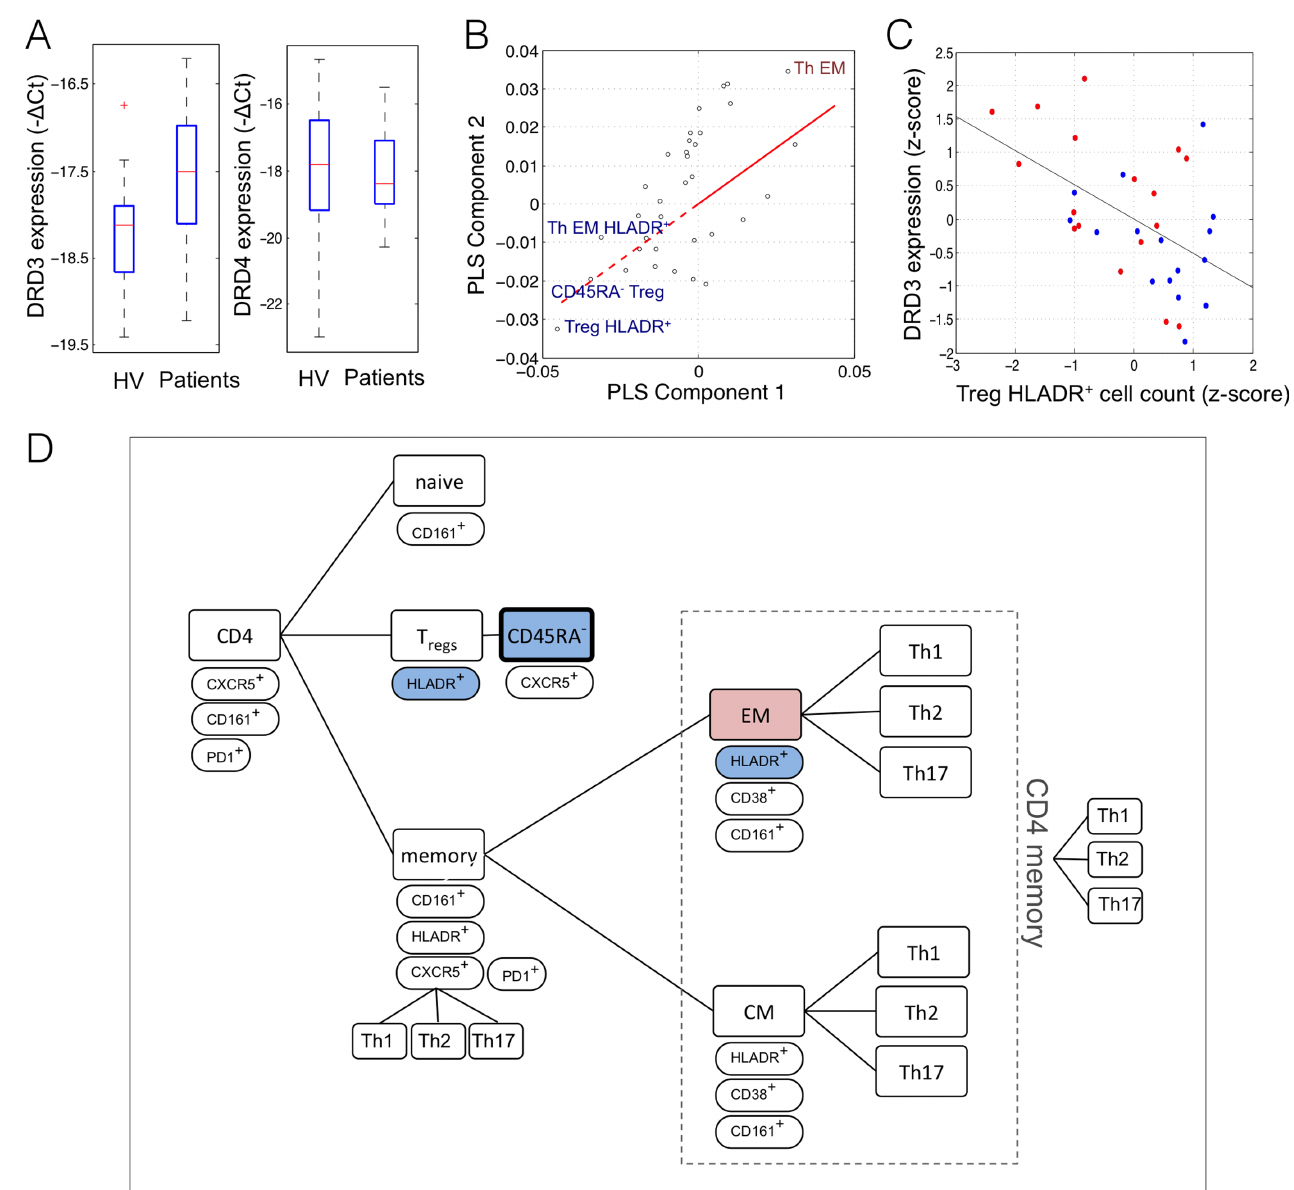
Fig 3. Dopamine D3 receptor gene expression on peripheral T cells. (A) Boxplots showing increased DRD3 receptor gene expression by CD4 + T cells in patients with schizophrenia compared to healthy volunteers (HV) ( t = -2.2, df = 30, P = 0.035), with no significant group-difference in DRD4 expression. (B) Scatter plot of the weight of individual predictor variables (immune cell populations) on the first two components of the PLS analysis. The loading vector for the response variable ( DRD3 expression) is shown with the solid (dashed) red line indicating increased (decreased) DRD3 expression. Text labels identify four cell classes that had the highest positive weights (red text) or highest negative weights (blue text) on the first two PLS components (|Z| > 3; bootstrapping). The cell types most strongly predictive of DRD3 expression were HLADR + Treg and memory Treg. (C) Scatterplot shows the negative correlation ( r = -0.53, df = 30, P = 0.002) between DRD3 receptor expression and HLADR + Treg relative cell counts; red = cases, blue = controls. (D) Hierarchy of the 34 CD4 + sub-classes included in the PLS analysis, highlighting the 4 cell classes most strongly related to CD4 + DRD3 expression. Cell classes that were equally strongly negatively weighted in the case-control and within- group PLS analyses ( Figs 1 and 2 ) are highlighted in